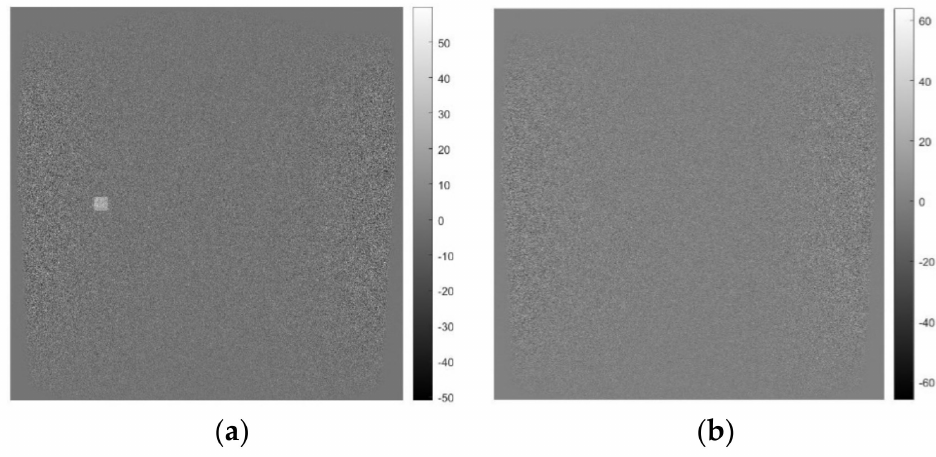
Figure 13. Results of pencil beam spot scanning method. 5 mg/mL: ( a ); 0.5 mg/mL: ( b